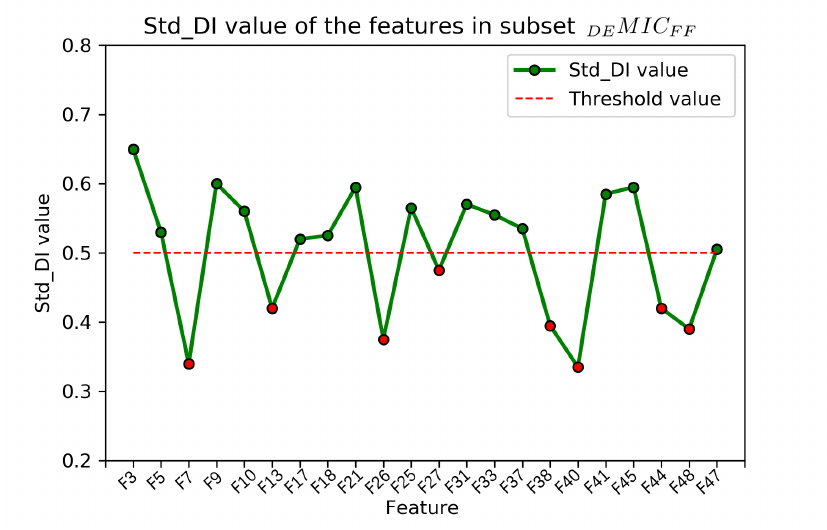
Figure 9. The Std DI calculation results of subset DE MIC FF .